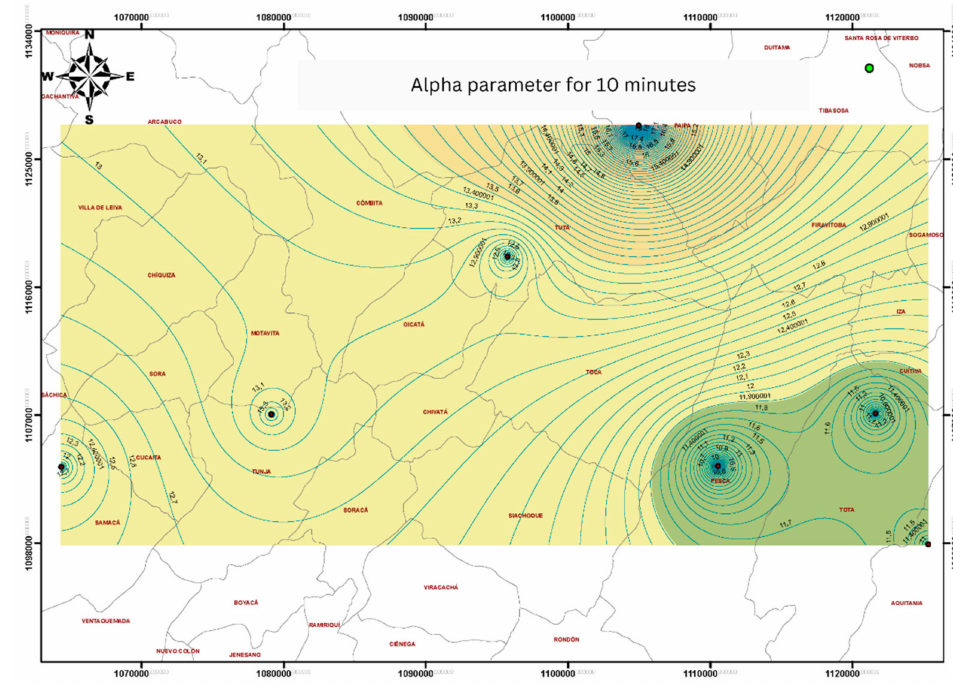
Figure 3. A regionalized map developed from the α parameter for 10 min.